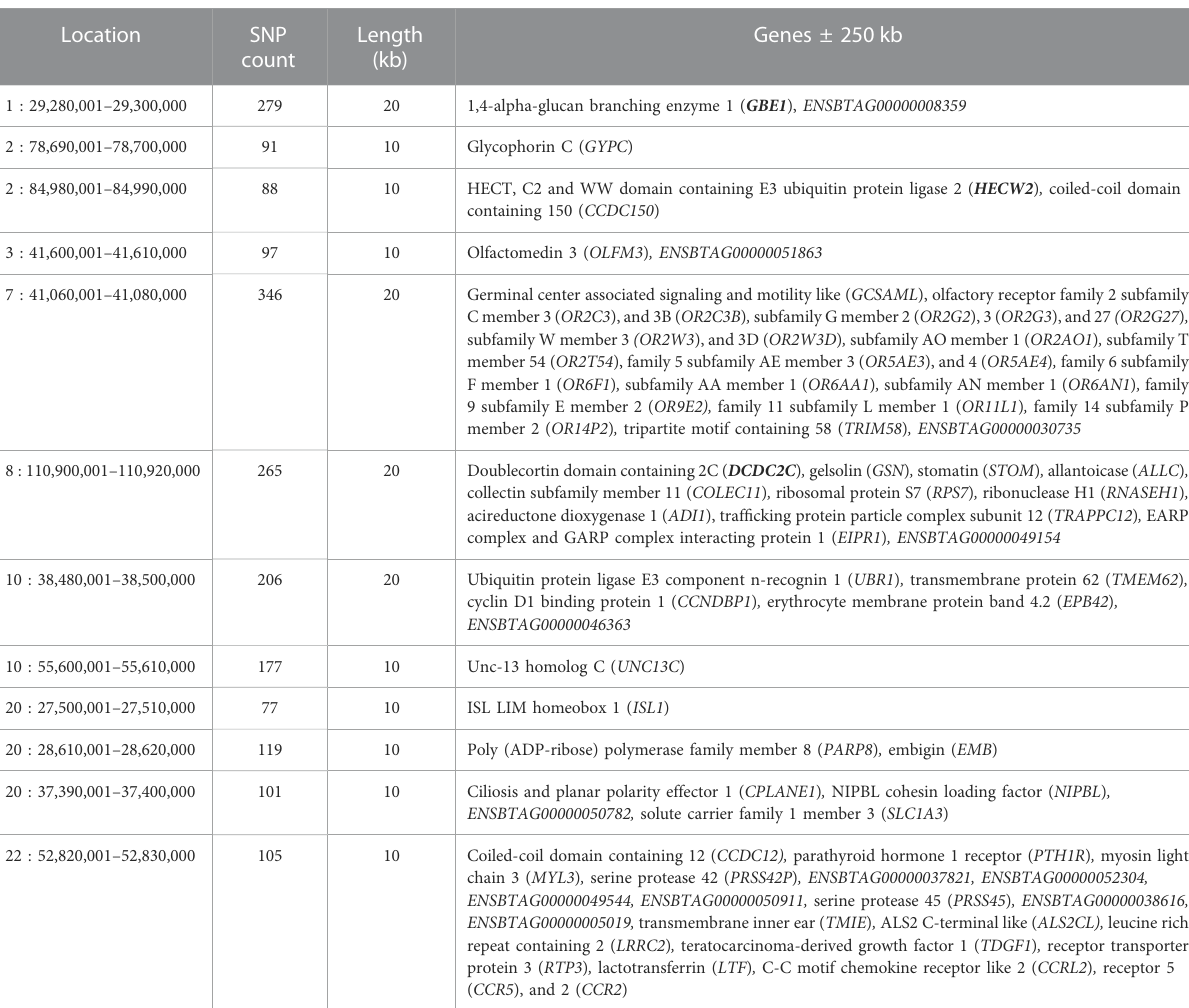
TABLE 2 Positional candidate genes in regions with the highest F ST values between DSN and Holstein. Genes in bold are located directly inside the windows with the highest F ST values. All other genes are located ± 250 kb from the start and end positions of the windows with the highest F ST values. Consecutive windows displaying the same genes are shown together, this is the case for windows in BTA 1, 7, 8, and 10, whereof length is 20 kb.